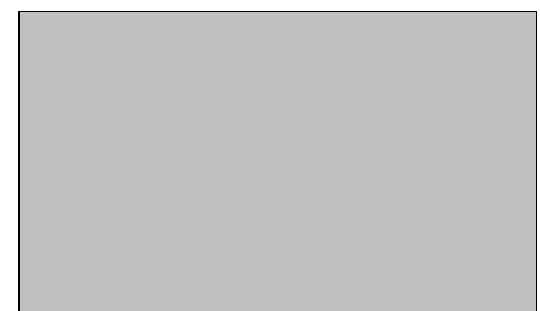
Table V : HIV infection and liver state